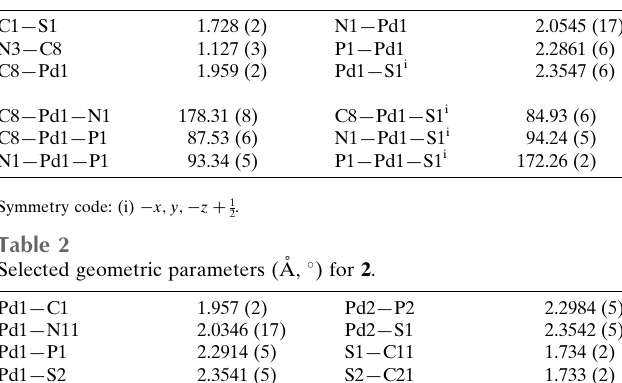
Table 1 Selected geometric parameters (A˚ , (cid:5) ) for 1 .